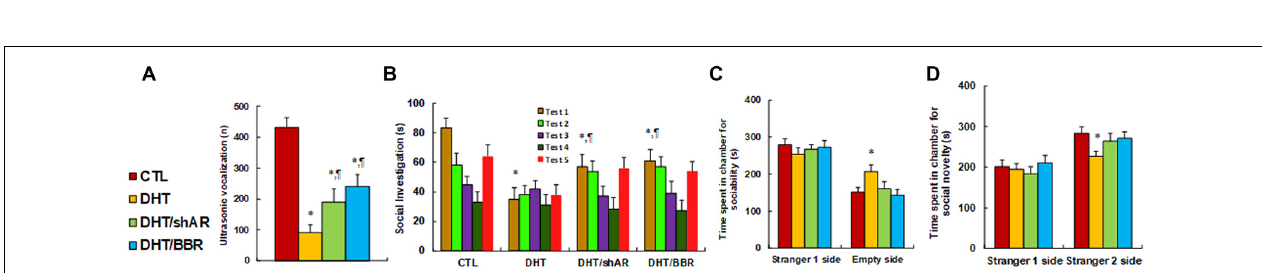
FIGURE 3 | Prenatal treatment of either shAR or BBR ameliorates prenatal DHT exposure-induced oxidative stress and mitochondrial dysfunction by AR suppression. The 2 month-old female rats received either CTL or DHT treatment, which involved either DHT with shAR lentivirus infusion in the amygdala (DHT/shAR) or DHT with BBR injection (DHT/BBR) during the 21-day pregnancy. The subsequent 2 month-old male offspring were sacrificed, and amygdala tissues and/or amygdala neurons were isolated for further analysis. (A) The mRNA levels for gene expression of AR, ER β and SOD2, n = 4. (B) The representative pictures for western blotting. (C) The quantitation of protein levels, n = 5. (D) In vivo superoxide anion release, n = 5. (E) Quantitation of 3-nitrotyrosine formation, n = 5. (F,G) The amygdala neurons were isolated for immunostaining by 8-oxo-dG and DAPI. (F) Quantitation of 8-oxo-dG staining, n = 5. (G) Representative pictures for 8-oxo-dG staining (green) and DAPI staining for nuclei (blue). (H) Mitochondrial DNA copies, n = 4. (I) Intracellular ATP levels, n = 5. ∗ P < 0.05, vs. CTL group; ¶ P < 0.05, vs. DHT group. Data were expressed as mean ± SEM.